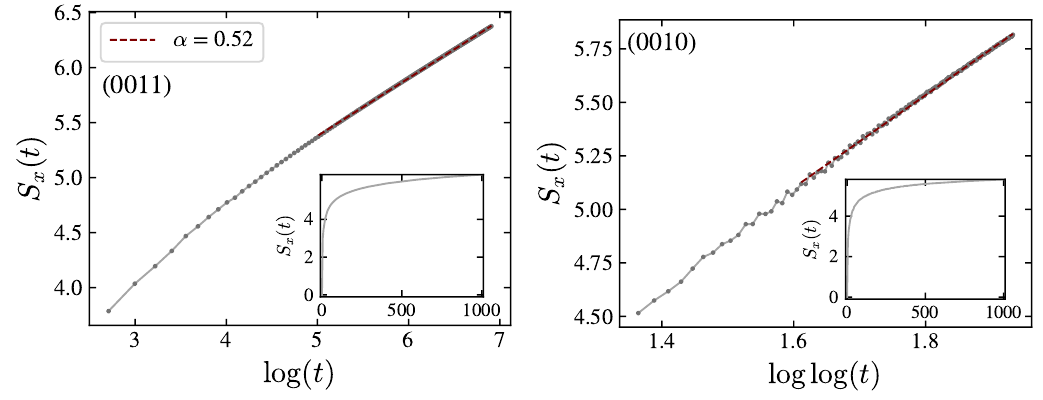
Figure 7: Entanglement entropy of particle one position as a function of time for case ( 0011 ) , without topological interface, and case ( 0010 ) , with a ‘01’ interface. In the first case (left pannel), there is a binding state for the two particles, and the entropy grows following a log law, with an exponent α ≈ 0.54; in contrast, for the second case (right pannel), a localized state is present at the origin, and the entropy growth is only loglog. The insets show the unscaled